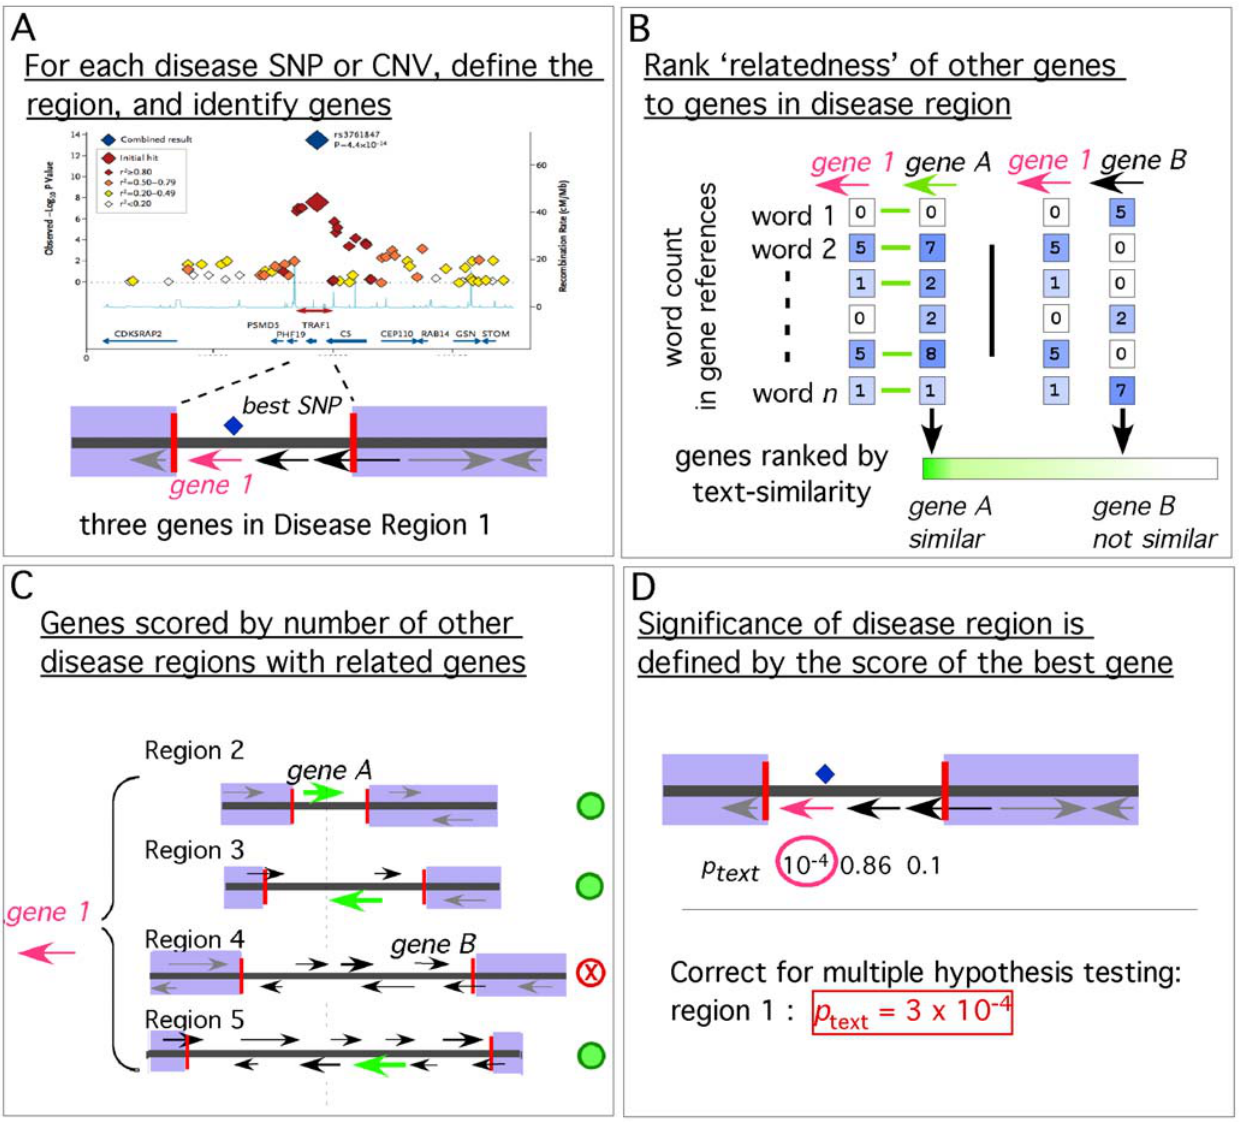
Figure 1. Gene Relationships Among Implicated Loci (GRAIL) method consists of four steps. (A) Identifying genes in disease regions. For each independent associated SNP or CNV from a GWA study, GRAIL defines a disease region; then GRAIL identifies genes overlapping the region. In this region there are three genes. We use gene 1 (pink arrow) as an example. (B) Assess relatedness to other human genes. GRAIL scores each gene contained in a disease region for relatedness to all other human genes. GRAIL determines gene relatedness by looking at words in gene references; related genes are defined as those whose abstract references use similar words. Here gene 1 has word counts that are highly similar to gene A but not to gene B . All human genes are ranked according to text-based similarity (green bar), and the most similar genes are considered related. (C) Counting regions with similar genes. For each gene in a disease region, GRAIL assesses whether other independent disease regions contain highly significant genes. GRAIL assigns a significance score to the count. In this illustration gene 1 is similar to genes in three of the regions (green arrows), including gene A . (D) Assigning a significance score to a disease region. After all of the genes within a region are scored, GRAIL identifies the most significant gene as the likely candidate. GRAIL corrects its significance score for multiple hypothesis testing (by adjusting for the number of genes in the region), to assign a significance score to the region.